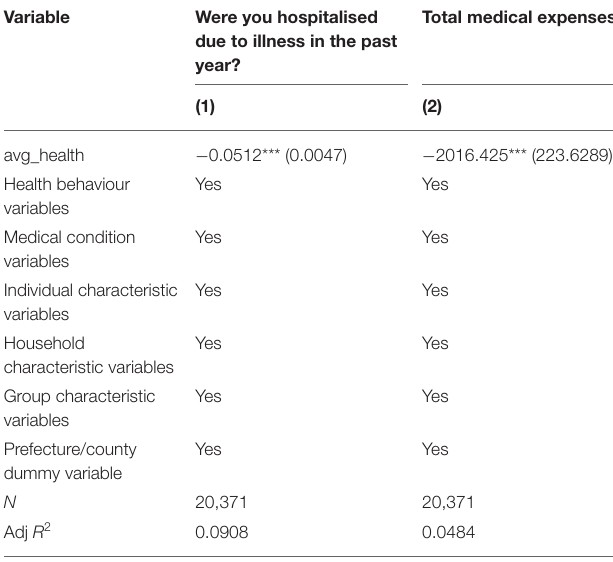
TABLE 4 | Robustness test based on objective health